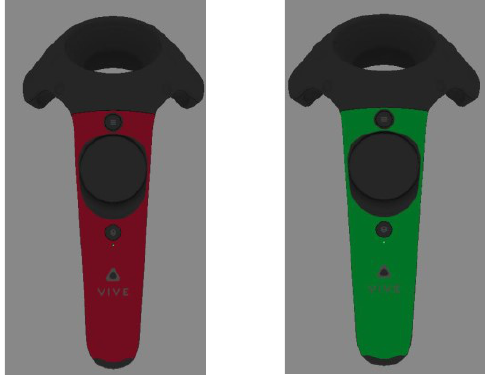
Figure 3 . The final model of each